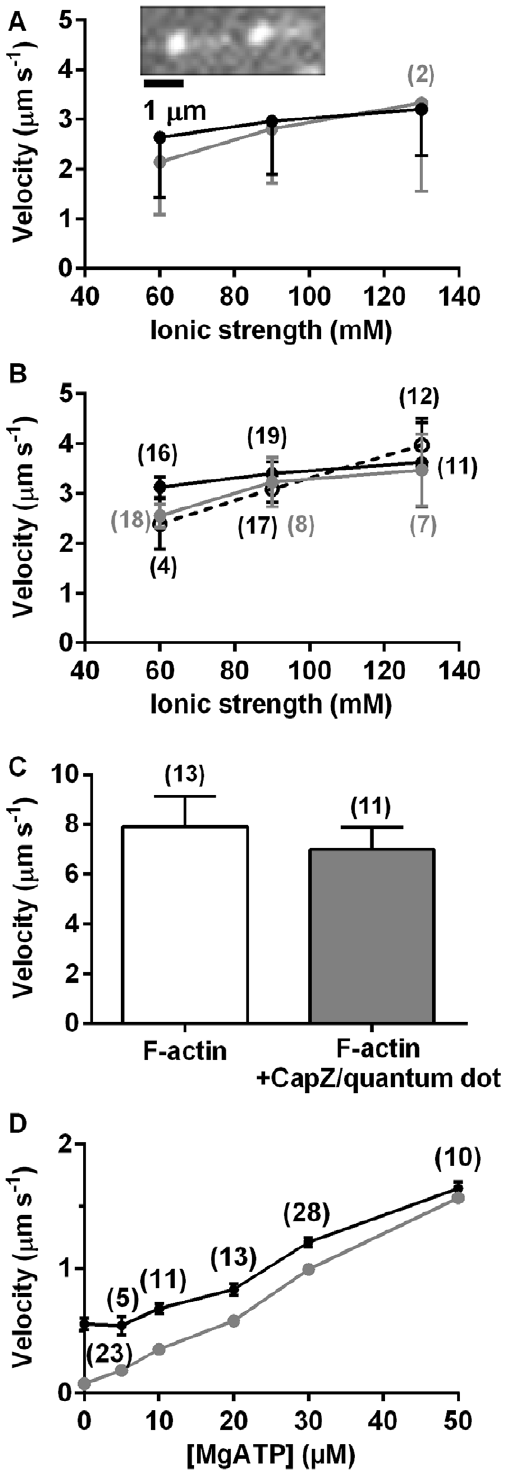
Figure 5. Effect of CapZ binding to F-actin on HMM propelled actin filament velocity. A . Sliding velocities at different ionic strengths for F-actin with (grey) and without (black) CapZ/quantum dot complex (n= 3 experimental occasions and different HMM preparations unless indicated in figure; . 17 filaments analysed for each condition). Temperature: 22 u C. Inset : two subsequent images (interval: 1.6 s) of HMM propelled RhPh-labelled F-actin (sliding to the right) with quantum dot attached to the trailing end via CapZ. B.